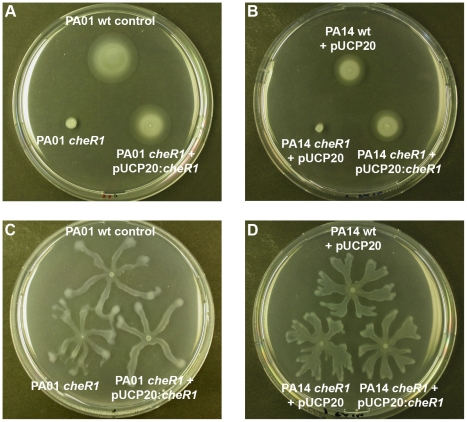
Motility phenotype of the cheR1 mutant and the complemented strain of PA01 (A, C) and PA14 (B, D).(A, B) Swimming assays were performed on minimal medium soft agar plates supplement with 0.3% agar. The impaired swimming motility of the cheR1 mutant can be complemented by providing the cheR1 gene in trans. (C, D) Swarming assays were performed on minimal medium plates supplemented with 0.5% agar. All strains, the wild-type/wild-type control, the cheR1 mutant and the complemented cheR1 mutant, were capable of swarming.